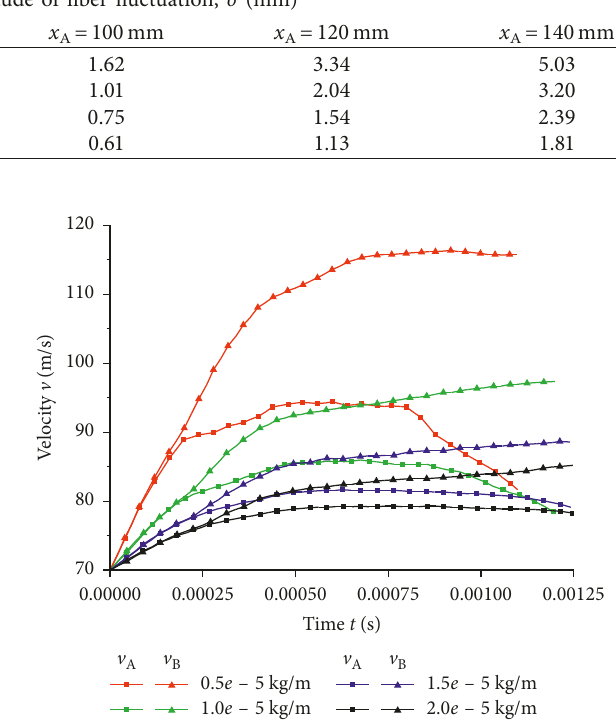
Figure 11: v x A and A curves with different linear densities and